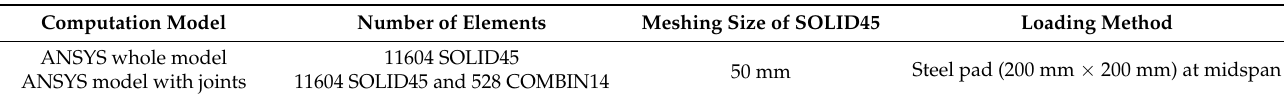
Table 3. Details of the models under the action of 200 kN.